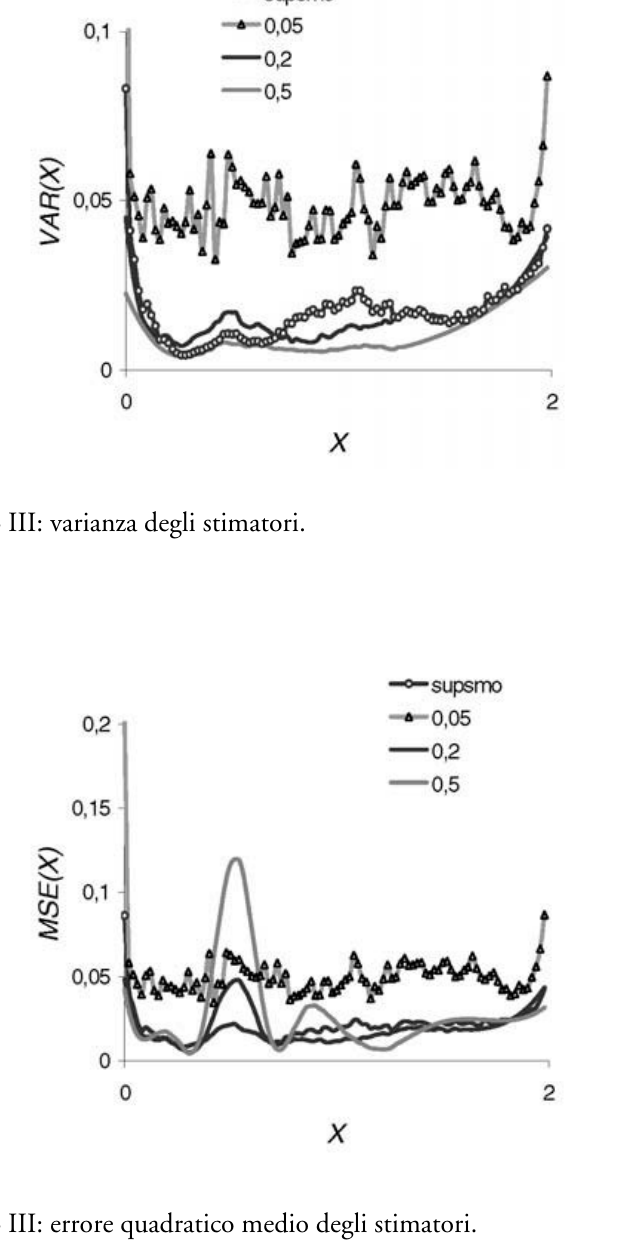
Figura 12 – Modello III: errore quadratico medio degli